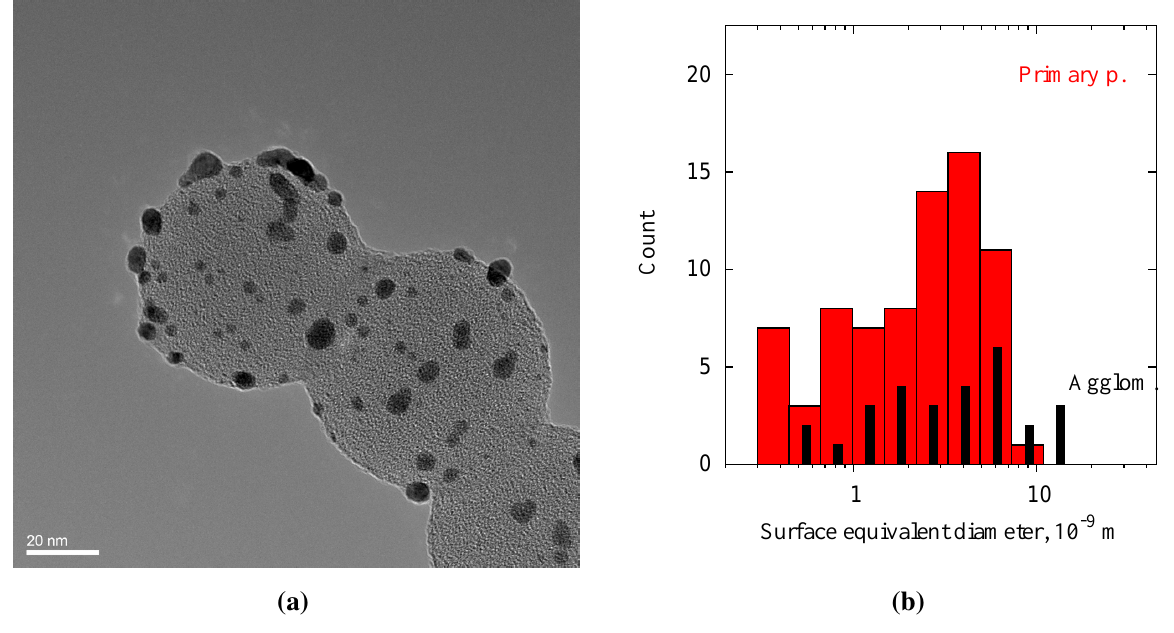
Figure 5. Au clusters deposited on polystyrene (PSL) nanospheres. ( a ) TEM micrograph, 20-nm scale bar; and ( b ) size distribution of primary (round) and agglomerated cluster domains, 105 in